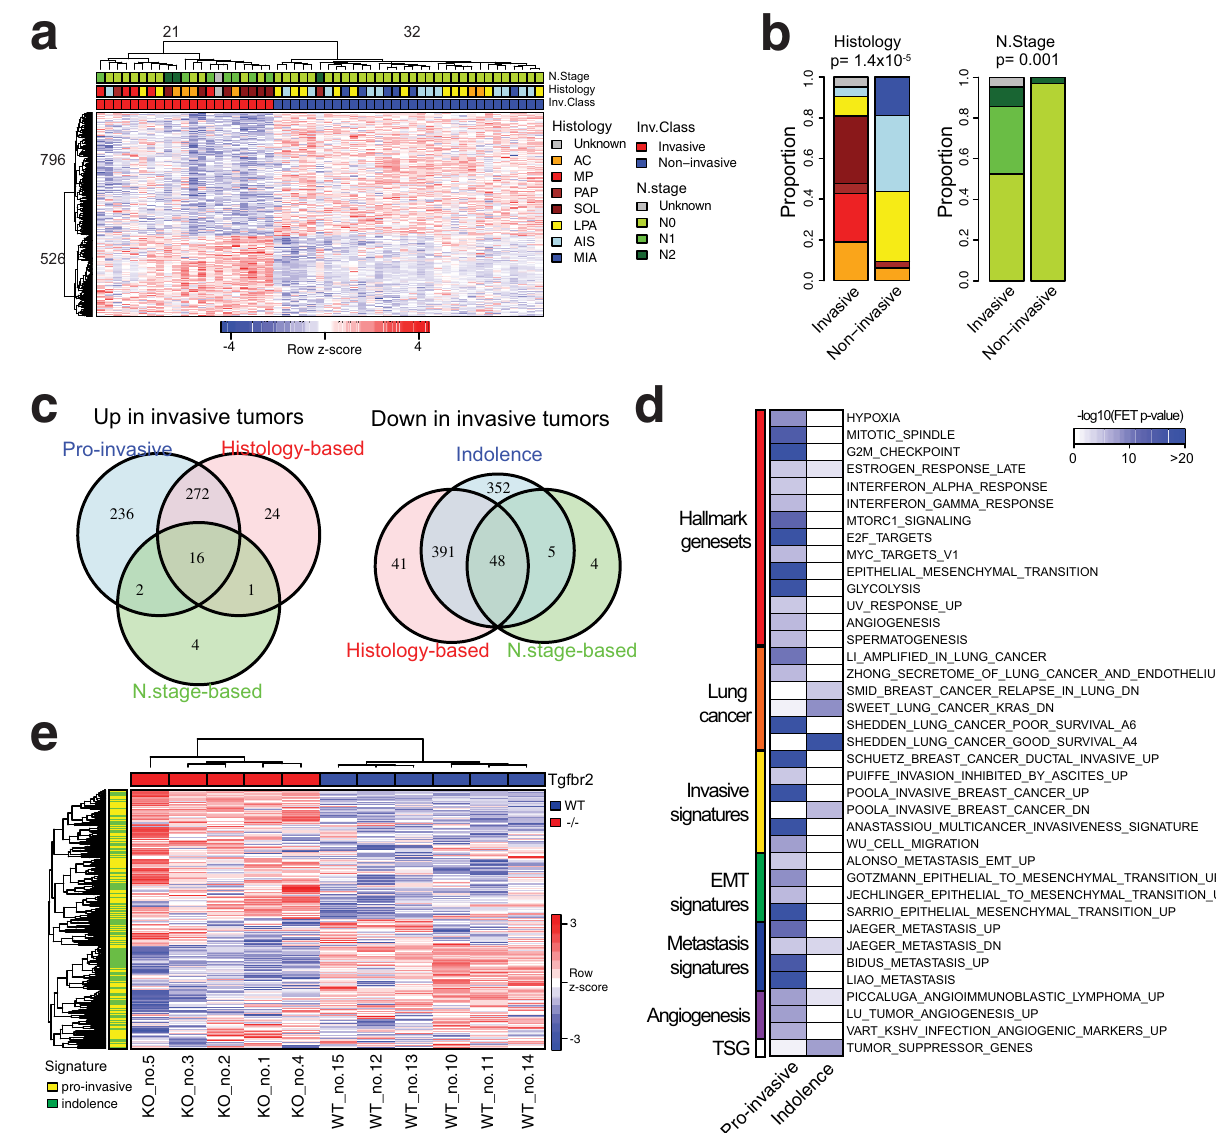
Fig. 1 Pro-invasive and indolence signature genes associated with tumor invasion at early-stage lung adenocarcinoma. a Invasiveness signature genes separating 53 early-stage lung adenocarcinoma into invasive and non-invasive tumors. “ Complete ” method was used for unsupervised clustering. b Comparison of the tumor clusters based on the signature genes with histological subtypes and nodal stages of the tumors. P -values of association are measured by a two-tailed Chi-Square test. Color codes for histology and nodal stages are same as panel ( a ). c Comparison of the gene numbers of pro- invasive and indolence signatures with differentially expressed genes based on histological subtypes (AIS, MIA, LPA vs AC, MP, PAP, SOL) and nodal stage (N0 vs N1 + ). Lists of genes in each category are provided in Source Data fi les. d Association of pro-invasive and indolence signatures with MSigDB gene sets including Hallmark, lung cancer-related genes, tumor invasion, or metastasis-related gene sets. e Unsupervised clustering of 11 tumors (5 Tgfbr2 − / − and 6 Tgfbr2 wt mice from GSE27717) based on the signature genes. “ Complete ” method was used for unsupervised clustering. Expression pro fi les of the signature genes are provided in Source Data fi